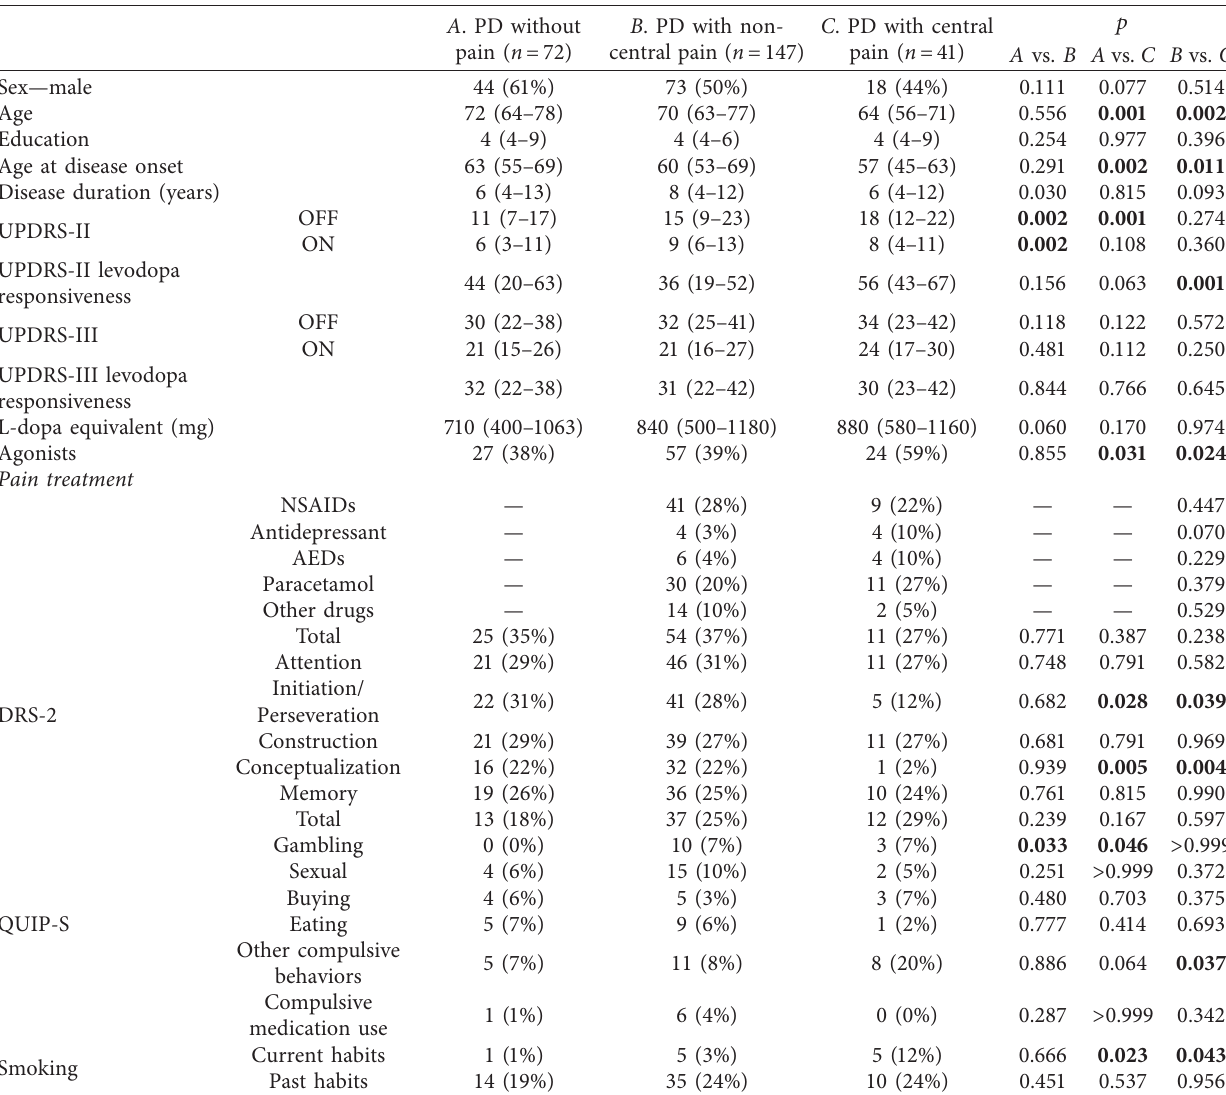
Table 1: Demographic, clinical, and therapeutic characteristics of Parkinson’s disease patients according to pain